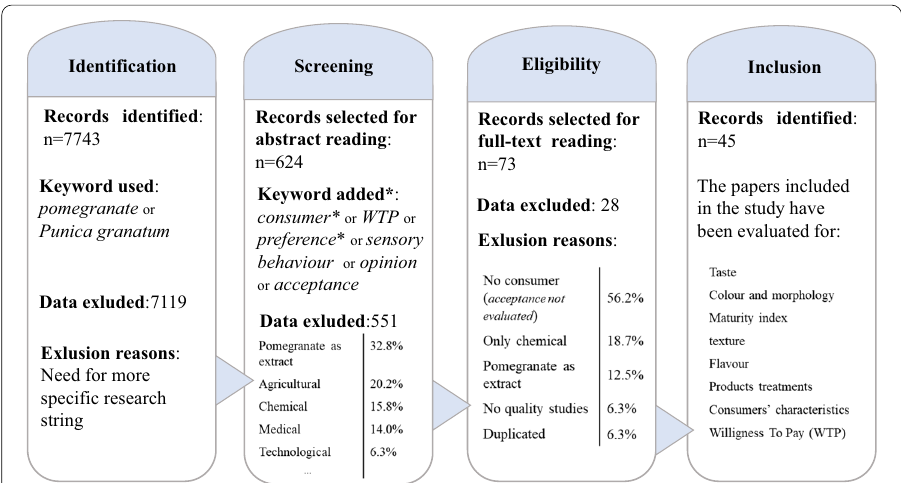
Fig. 2 Article selection process according to the PRISMA flow diagram